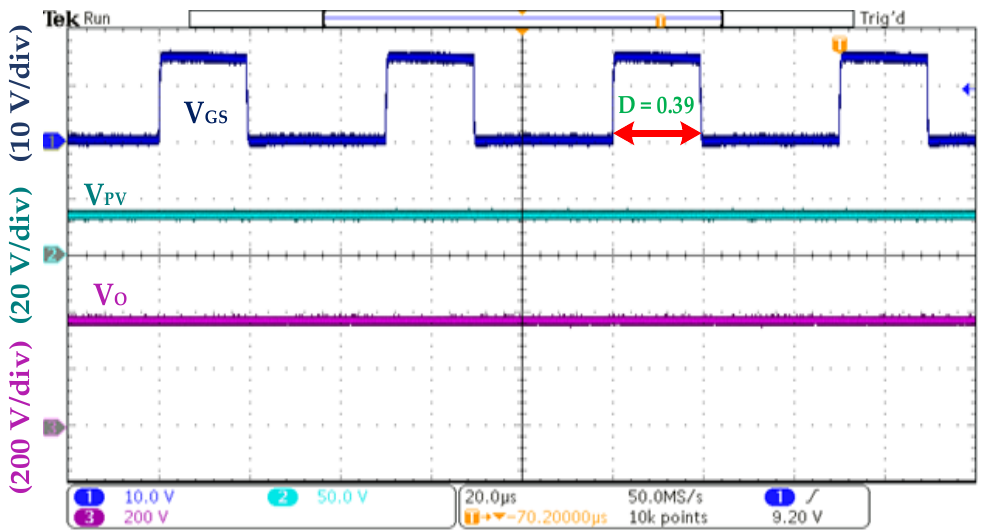
Figure 19. Experimental waveform for the gate source voltage (V GS ), solar photovoltaic simulator output voltage (V PV ), and output voltage (V o ) for the proposed HVGSU converter at the 0.39 duty cycle (Hor: 20 µs/div).